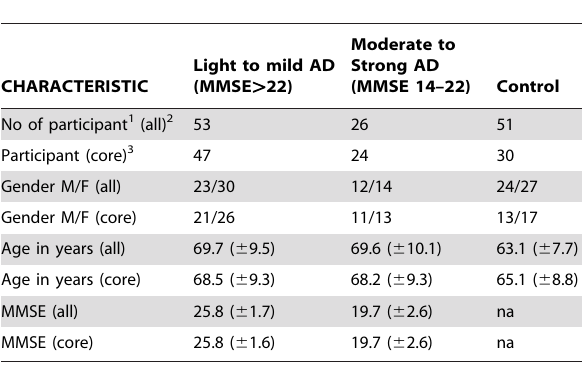
Table 1. Characteristic of study and participants for all centers and core